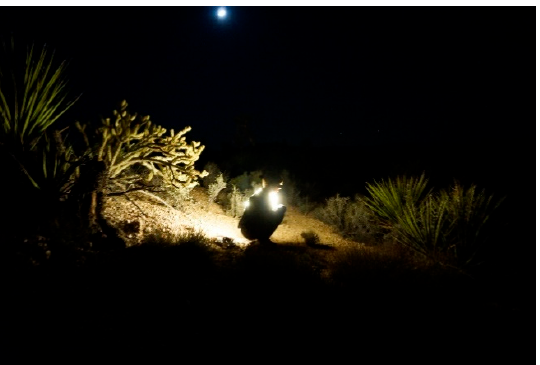
Figure 2. Explorer’s Lightspace in Mojave Desert. The wearable light creates a lit-up space around the wearer.